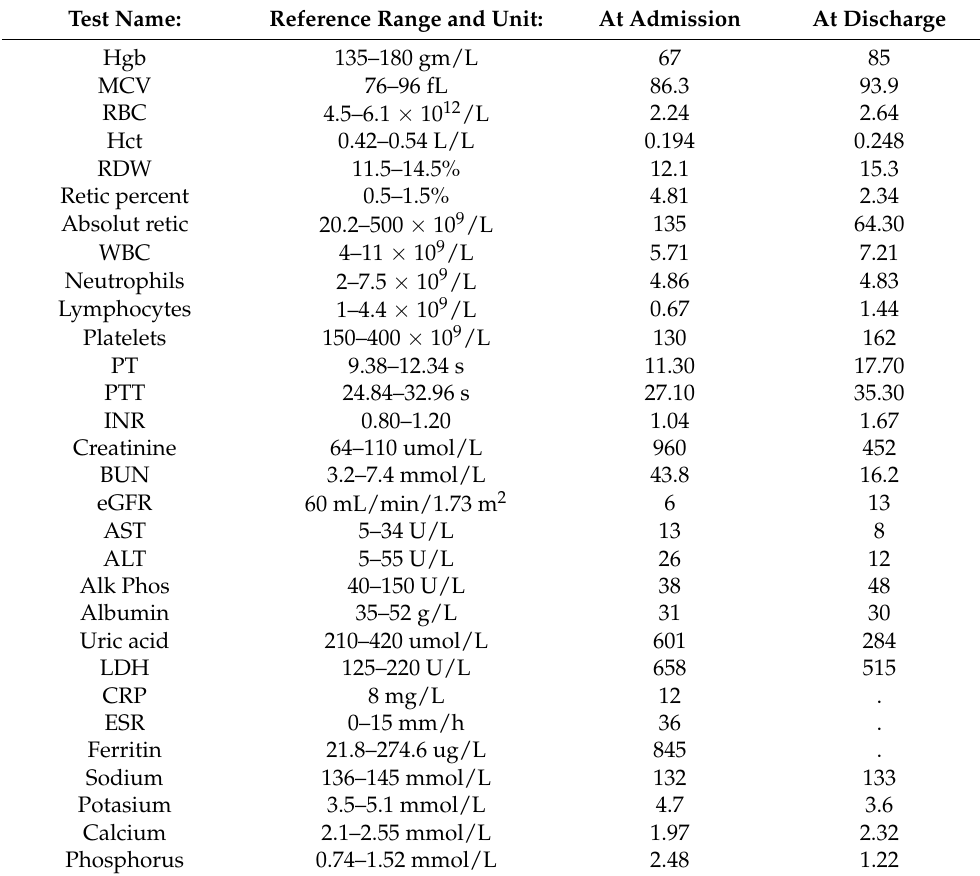
Table 1. Important laboratory values at the time of admission and